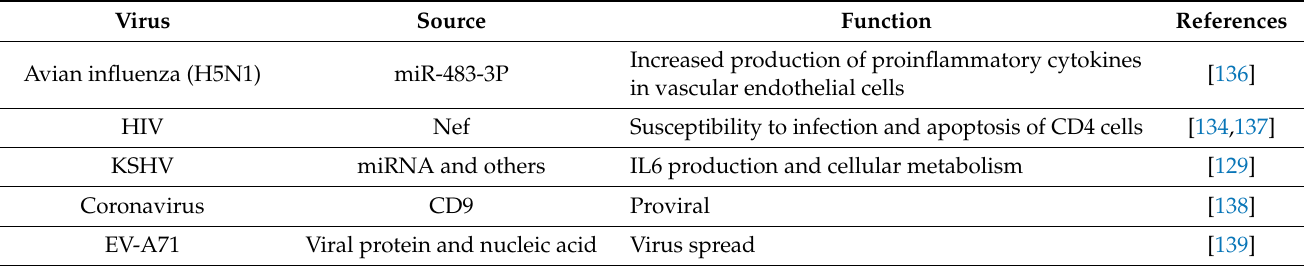
Table 3. Exosomes in the pathogenesis of viral